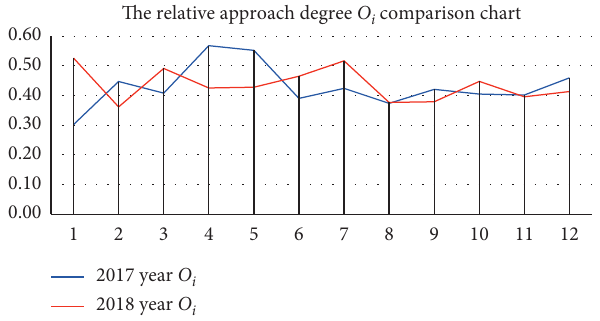
Figure 5: Comparison of relative proximity degree. Table 8: The results of the multiple coupling coordinated development degree D i of the collection and distribution system of Tongchuan Depot in 2018.